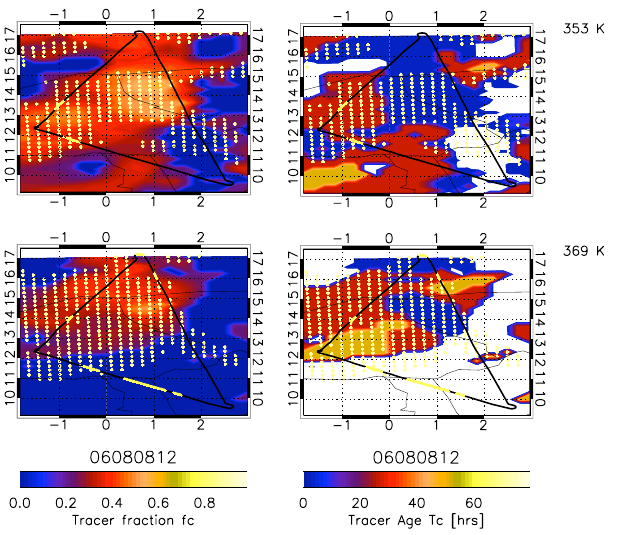
Fig. 8. As Fig. 7 but for the 8 August 2006 at 15:00UTC .